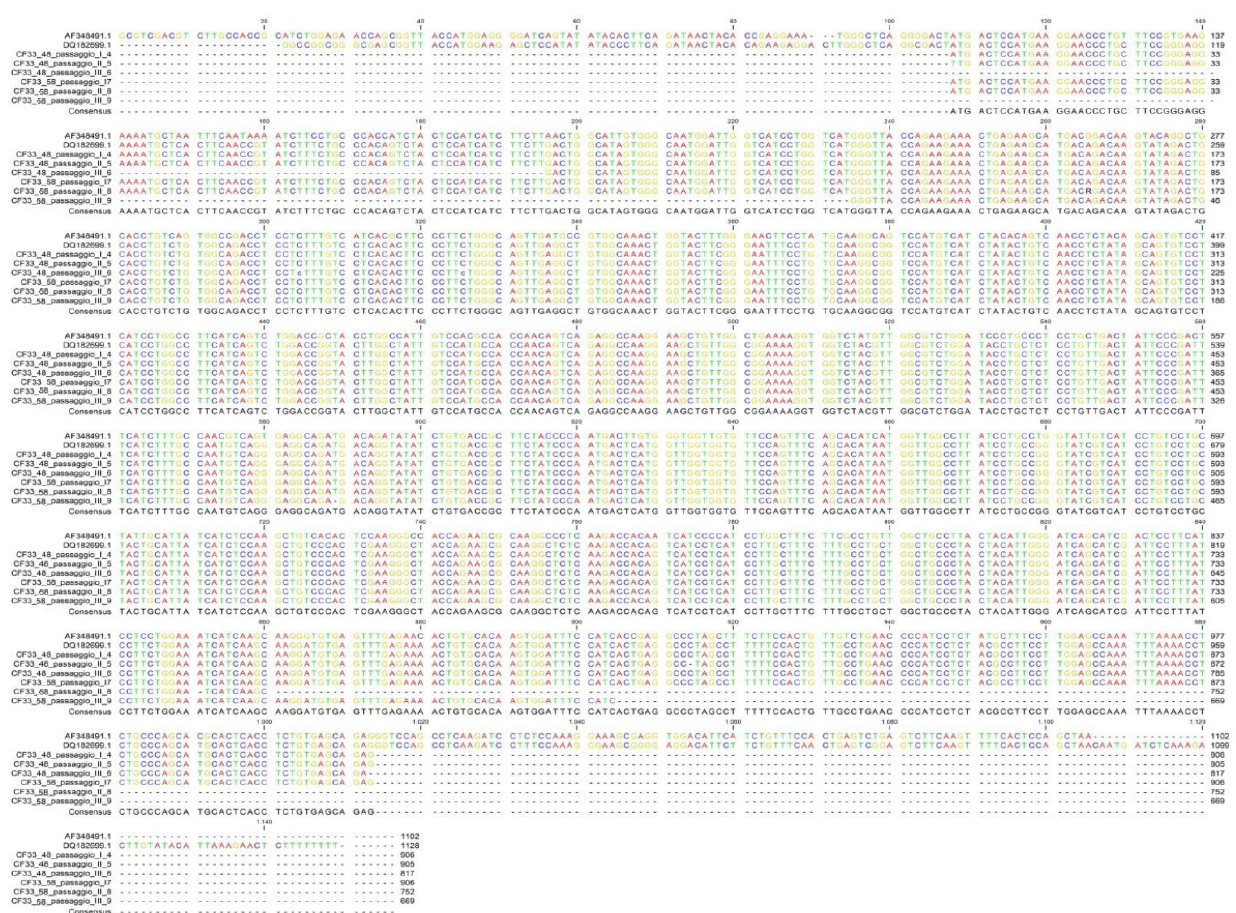
Figure 5. CXCR4 sequencing: alignment of the obtained sequences with CXCR4 human reference (AF348491.1) and CXCR4 canine reference (DQ182699.1) sequences.